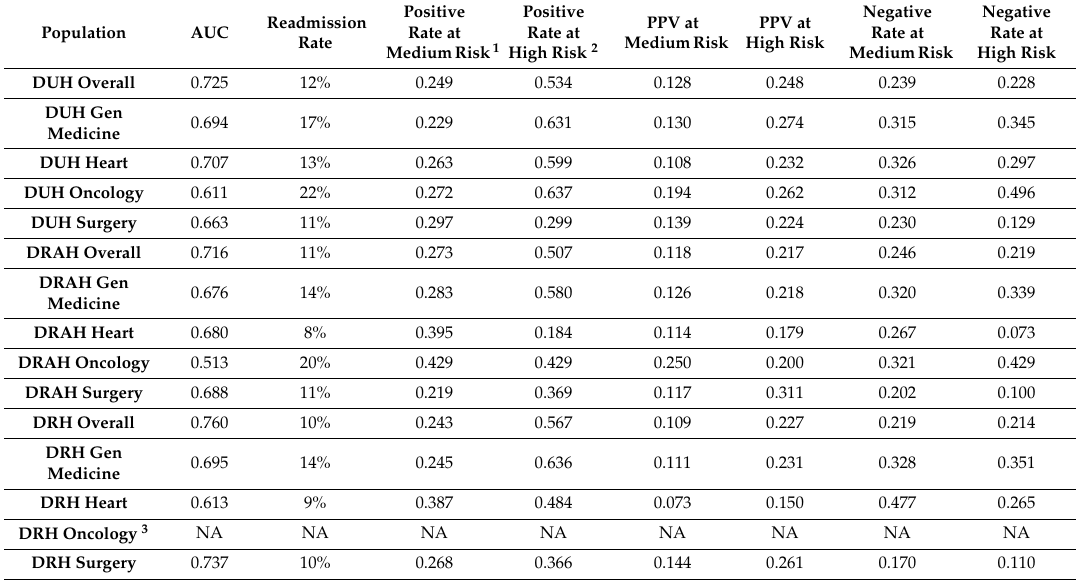
Table 2. Performance Metrics for Readmission.